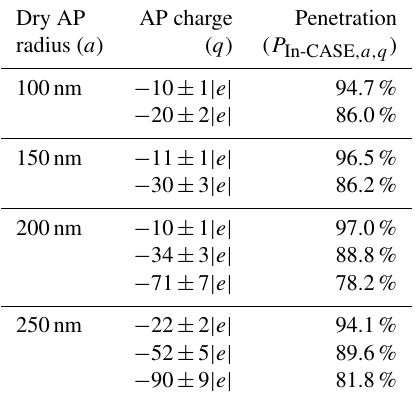
Table 3. Measured penetration for the experimental